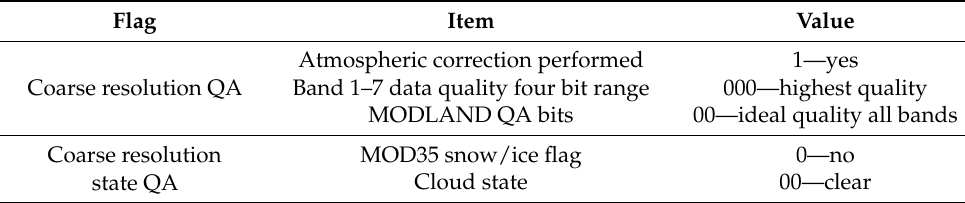
Table 3. Quality control for the MODIS CMG data. Flag Item Value Atmospheric correction performed Coarse resolution QA